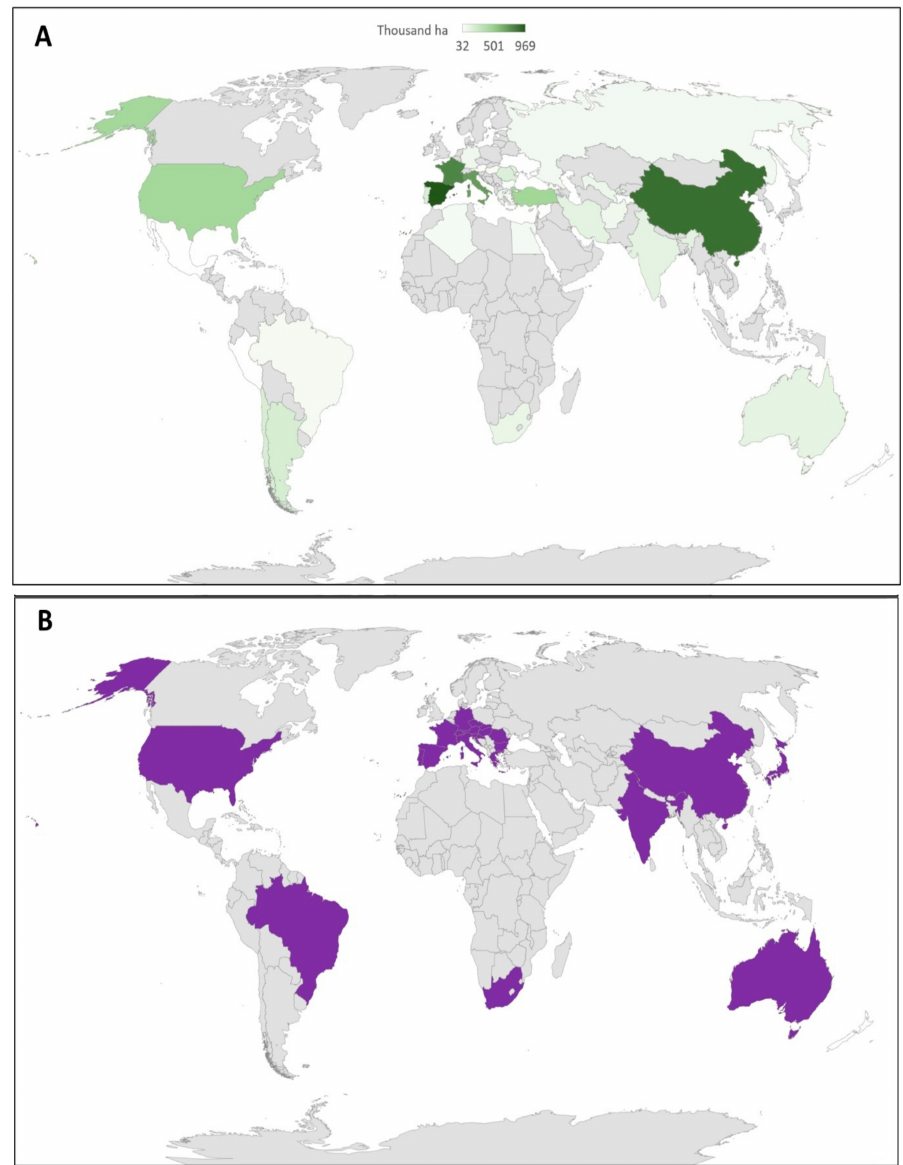
Figure 2. Global vine-growing areas allocated for the production of wine grapes, table grapes, or dried grapes in 2018 (sources Organisation of Vine and Wine and ood and Agriculture Organization of the United Nations) ( A ), compared to countries where P. viticola fungicide resistance was reported in 2020 ( B )